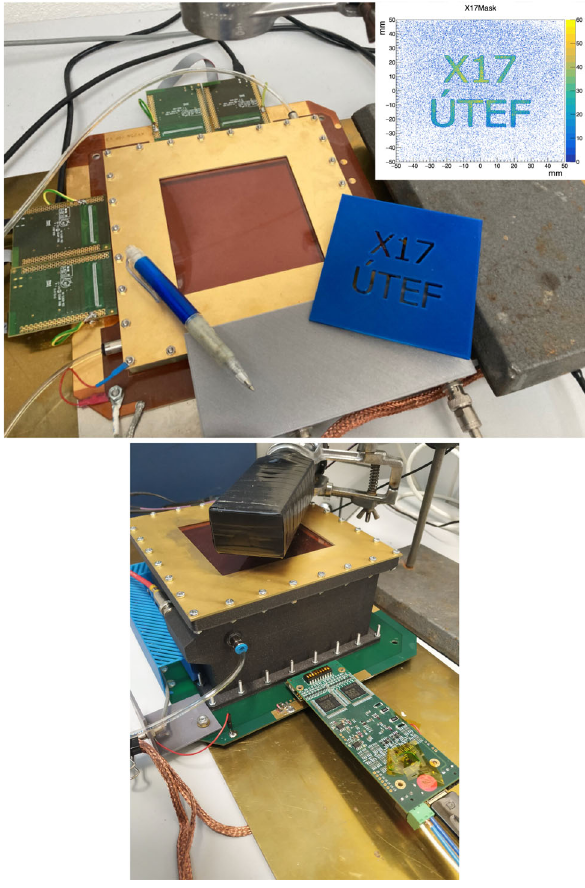
Fig. 14 Top: The 2D, 10 × 10 cm 2 triple GEM prototype with a simple imaging mask. Bottom: The TPC prototype with a SAMPA